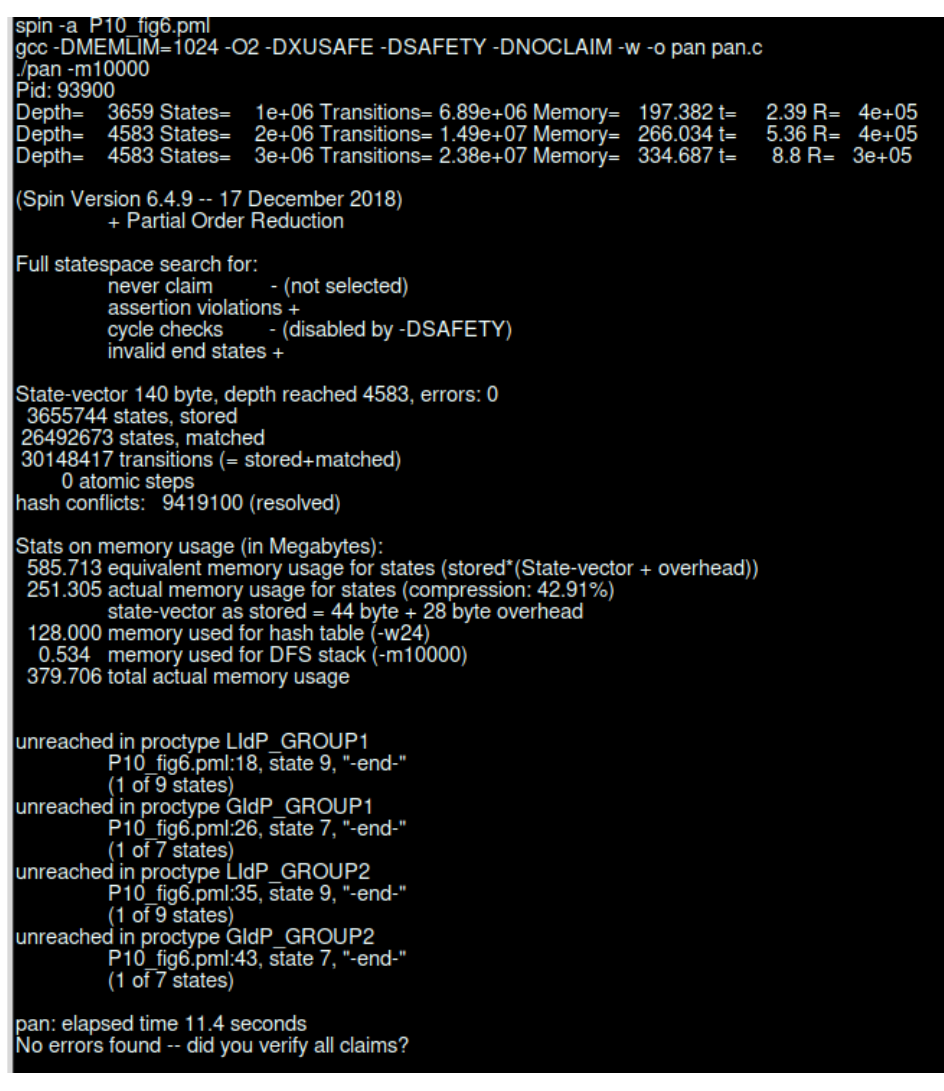
Figure 16. SPIN verification result for LIdP and GIdP interaction.